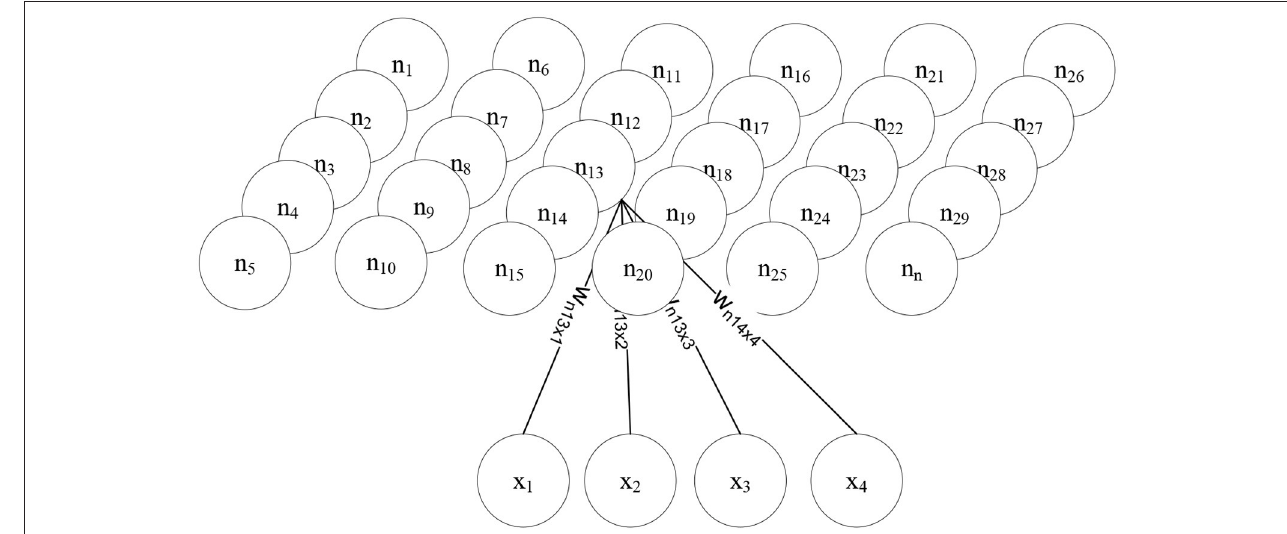
FIGURE 1 | Self-organizing feature map.